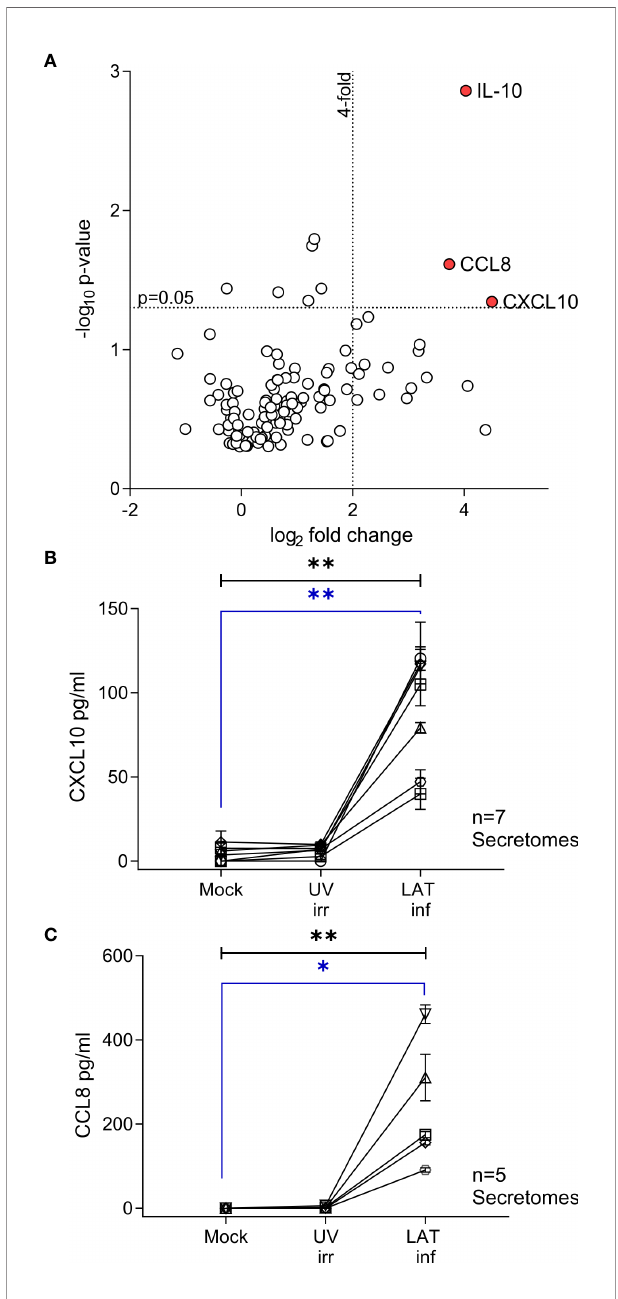
FIGURE 1 | CXCL10, CCL8 and cIL-10 are upregulated in the secretome from latently infected CD14+ monocytes. A Volcano plot summarizing the protein array results from 3 independent day 7 secretomes, signi fi cant (p<0.05) highly upregulated (values > 4-fold) proteins are indicated by the red circle and label. Data was analyzed as described in the methods. (A) Con fi rmatory ELISA results for the production of CXCL10 (B) and CCL8 (C) show that both cytokines are signi fi cantly upregulated in the HCMV latent infected secretome at day 7. Seven and six independent secretomes were analyzed for CXCL10 and CCL8 production respectively. Friedman 1-way ANOVA results are shown in black on the graph; CXCL10 p=0.0012** and CCL8 p=0.0031**. Post hoc Dunn ’ s test results are shown in blue CXCL10 p=0.004** and CCL8